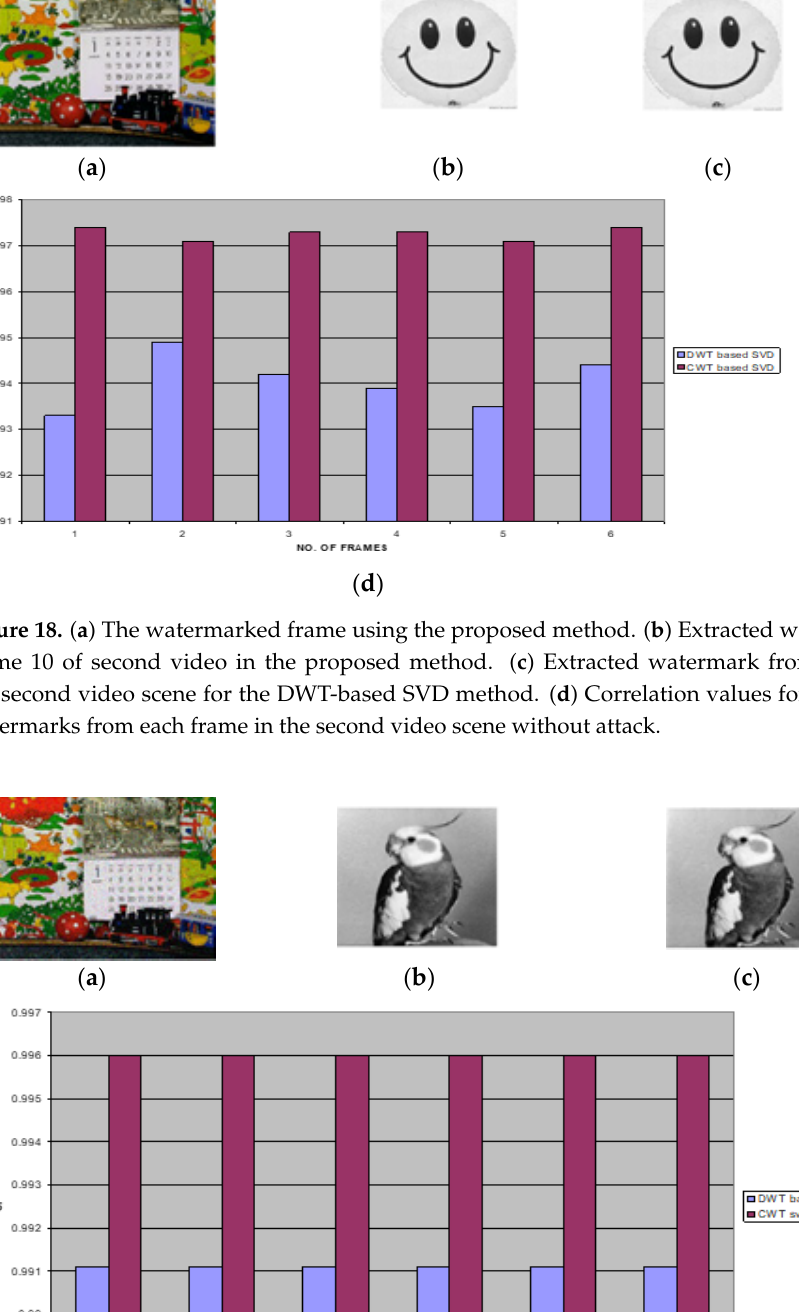
Figure 17. ( a ) The watermarked frame using the proposed method. ( b ) Extracted watermark from frame 10 of the first video scene in the proposed method. ( c ) Extracted watermark from frame 10 of the first video scene for the DWT-based SVD method. ( d ) Correlation values for the extracted wa- termarks from each six frames in the first video scene without attacks.